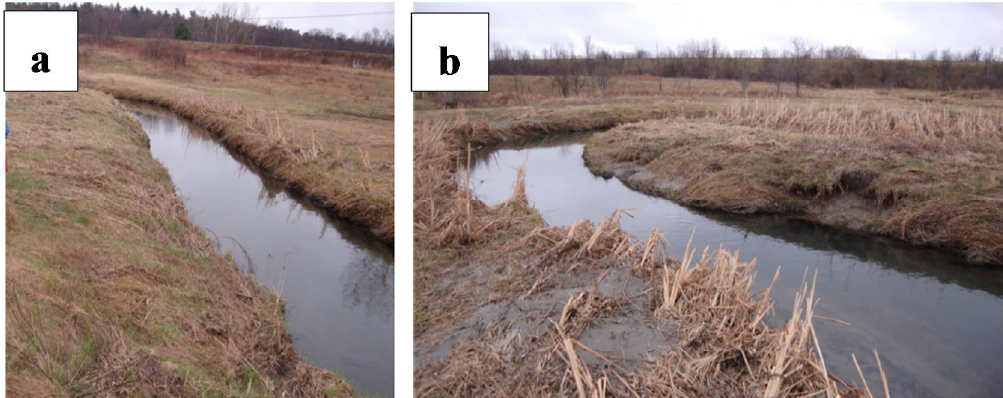
Figure 5. M3 facing downstream: ( a ) In the middle of M3, between the two major bends; ( b ) Last meander bend manifests regular meandering pattern with erosion on the outer band and deposition in the inner bank. Pictures were taken by the authors on 30 April 2014.